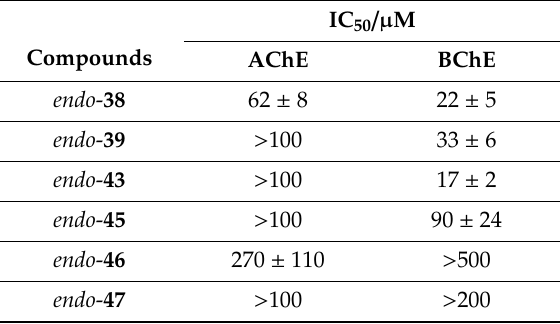
Table 3. Inhibition of human AChE and BChE by epoxides, alcohols and ethers